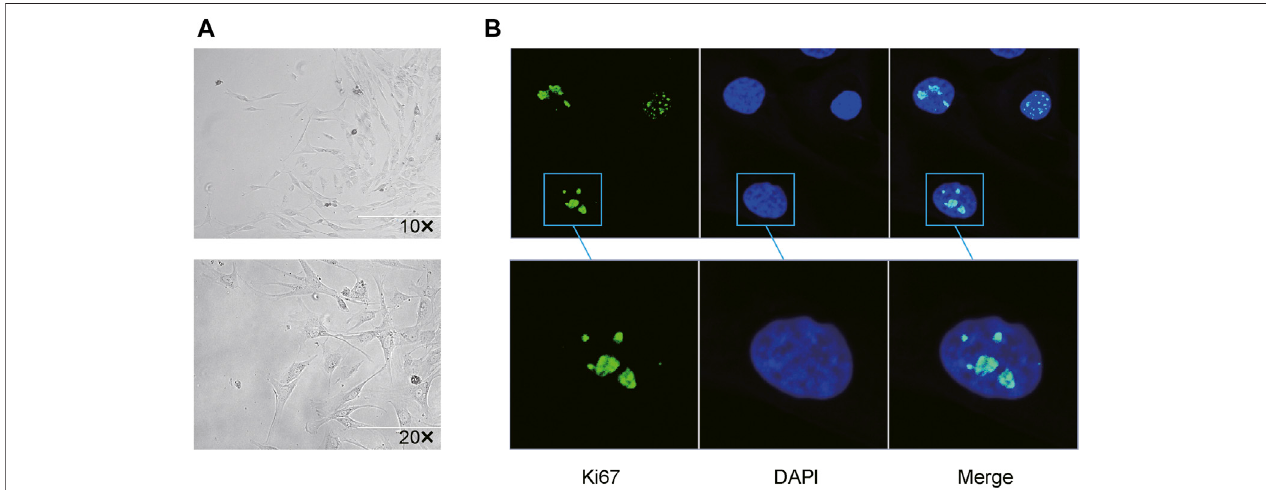
FIGURE 1 | Successful primary culture of keloid fi broblasts from the central region of the chronic keloids (A) Keloid fi broblasts could be observed via optical microscopy after 15 days of primary culture from 4 mini explants in the central regions (4/22) of the excised keloid tissues (Bar: 200 µm). (B) Using Ki-67 as a marker of cell proliferation, low-to-moderate proliferation (green) was observed in 2 passaged keloid fi broblasts from central regions of keloid tissue, with DAPI-stained cell nuclei (blue)